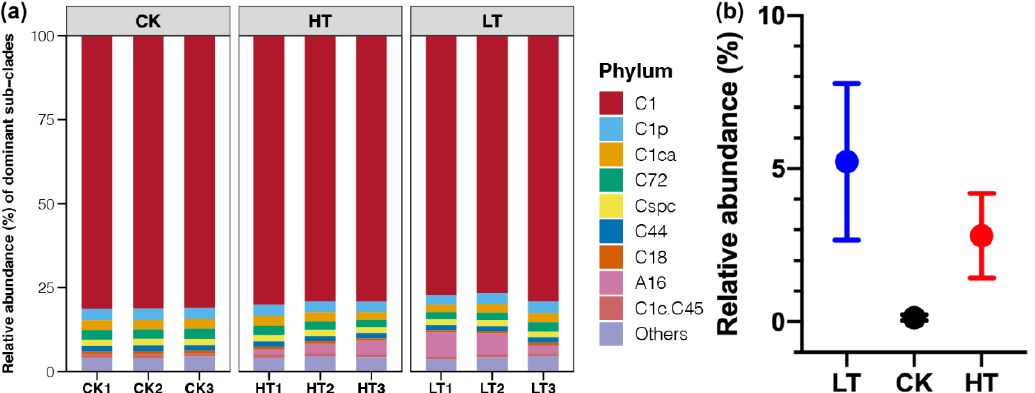
Figure 3. ( a ) The relative abundance of dominant dinoflagellate sub-clades across different samples. ( b ) Differences of the relative abundances of sub-clade A16 among different groups.